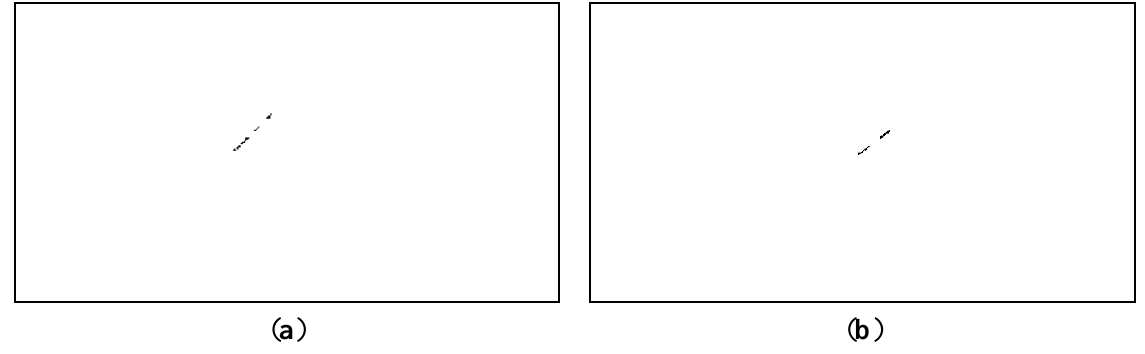
Figure 12. Satellite pixels, validated by area analysis. Detection results on the left image ( a ) and on the right image ( b